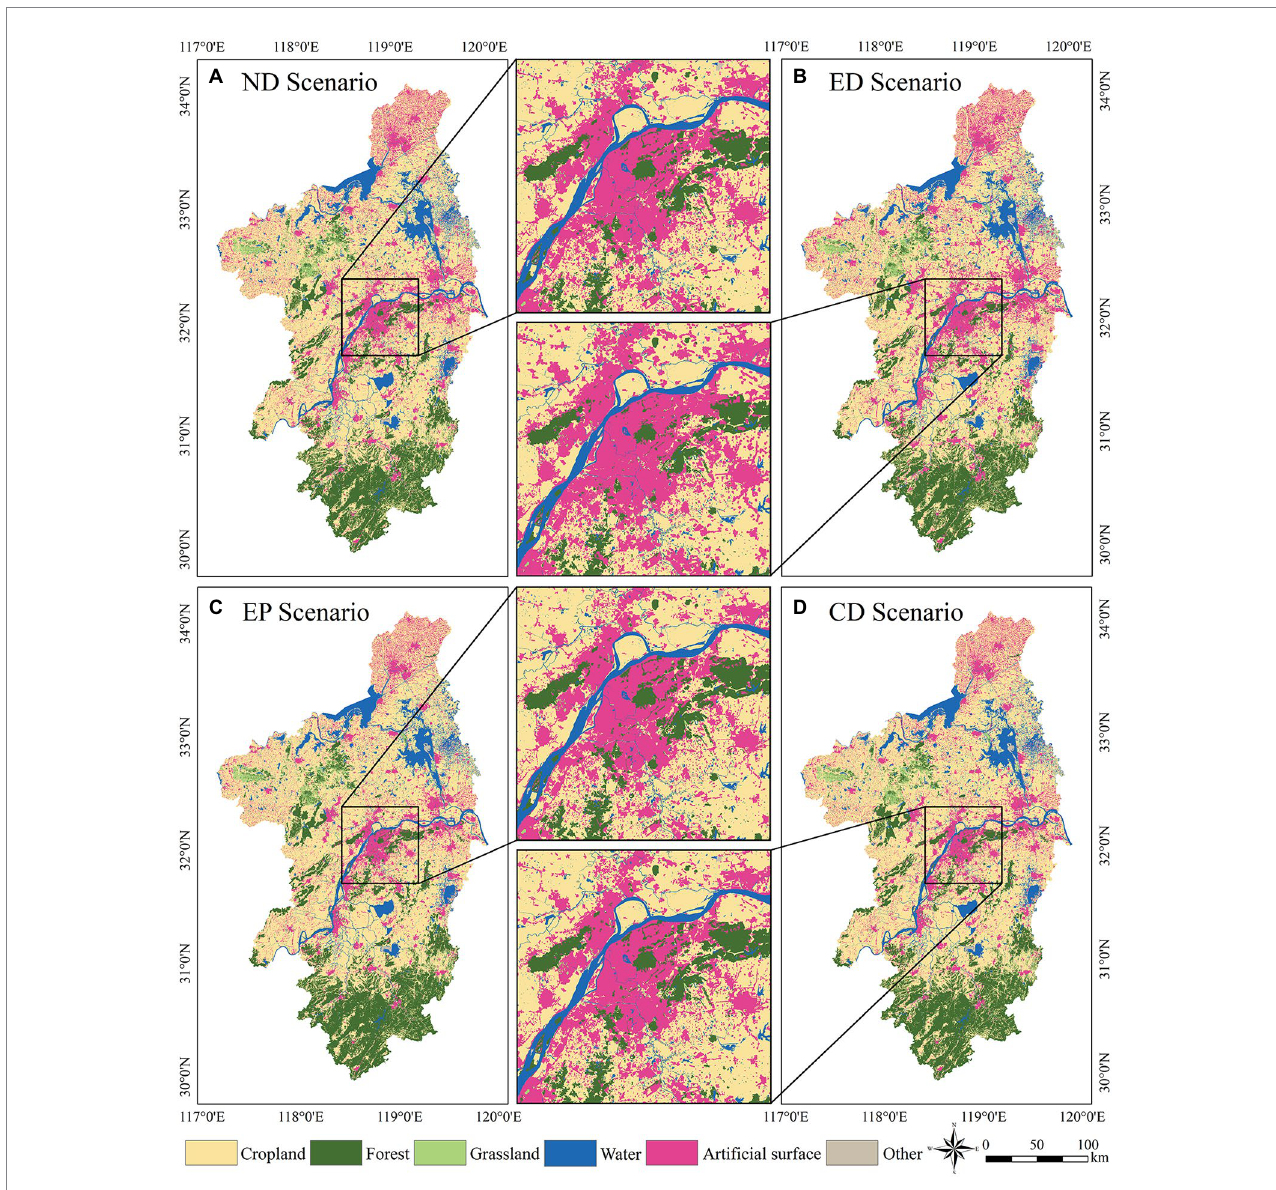
FIGURE 6 Simulation results of LULC in 2030 under four scenarios: (A) ND; (B) ED; (C) EP; and (D) CD.